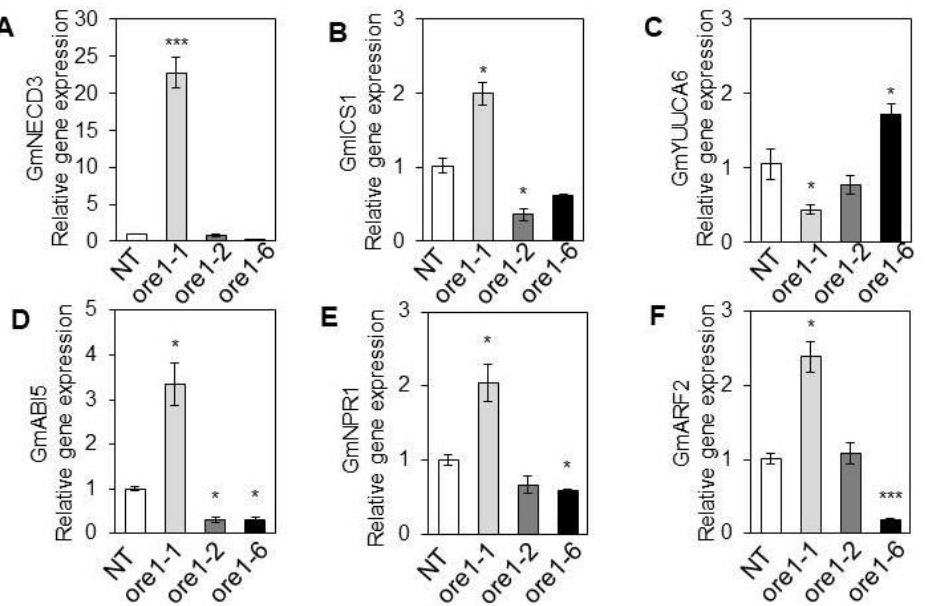
Figure 3. The relative abundance of phytohormone synthesis and signaling genes in soybean-expressed At-orre1 genes. ( A ) Abscisic acid (ABA)-synthesis-related gene 9-cis-epoxycarotenoid dioxygenase 3 (NECD3), GmNECD3 transcript level. ( B ) Salicylic acid (SA)-synthesis-related gene Isochorismate synthase 1 (GmICS1). ( C ) Auxin-synthesis-related gene GmYUCCA6 . ( D ) bZIP transcription factor level ABA INSENSITIVE 5 (ABI5), GmABI5 in ABA signaling. ( E ) Nonexpressor of pathogenesis-related genes 1, GmMYC2 transcription factor of SA-signaling. ( F ) AUXIN RESPONSE FACTOR 2 (ARF2), GmARF2 transcript level in auxin signaling. The expression levels were detected by quantitative polymerase chain reactions (qPCR). Asterisks indicate significant differences from wild-type (NT) and transgenic plants according to Tukey’s t -test; * p < 0.05, *** p < 0.001. Values are represented as mean ± SE ( n = 3).